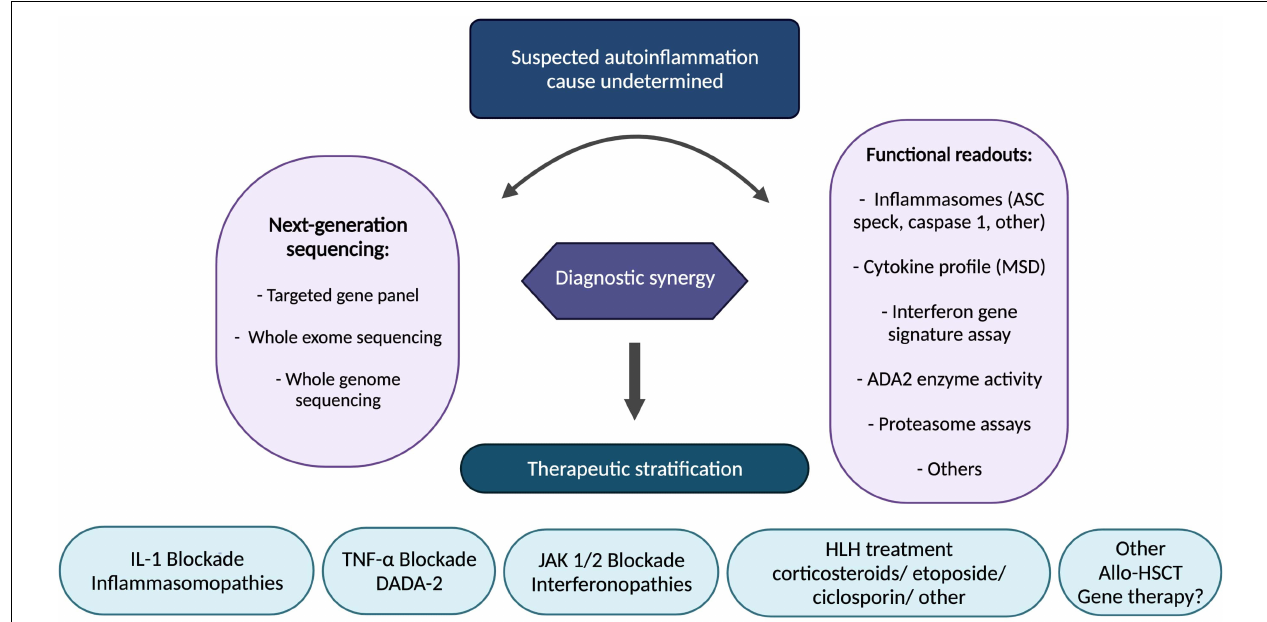
FIGURE 5 | Stratified therapeutic approach for autoinflammation. Functional readouts listed are non-exhaustive examples; other functional readouts pertinent to any genetic findings include STAT signalling (interferon pathway); ADA-2 enzyme activity; leucocyte intracellular MVK enzyme activity; peripheral blood RNA interferon signature, amongst others. ADA-2, adenosine-deaminase 2; Allo-HSCT, allogeneic haematopoietic stem cell transplantation; ASC, apoptosis associated speck-like protein containing a CARD; DADA2, deficiency of adenosine deaminase 2; HLH, hemophagocytic lymphohistiocytosis; IL-1, interleukin-1; JAK, janus kinase; MSD, meso scale discovery; TNF, tumour necrosis